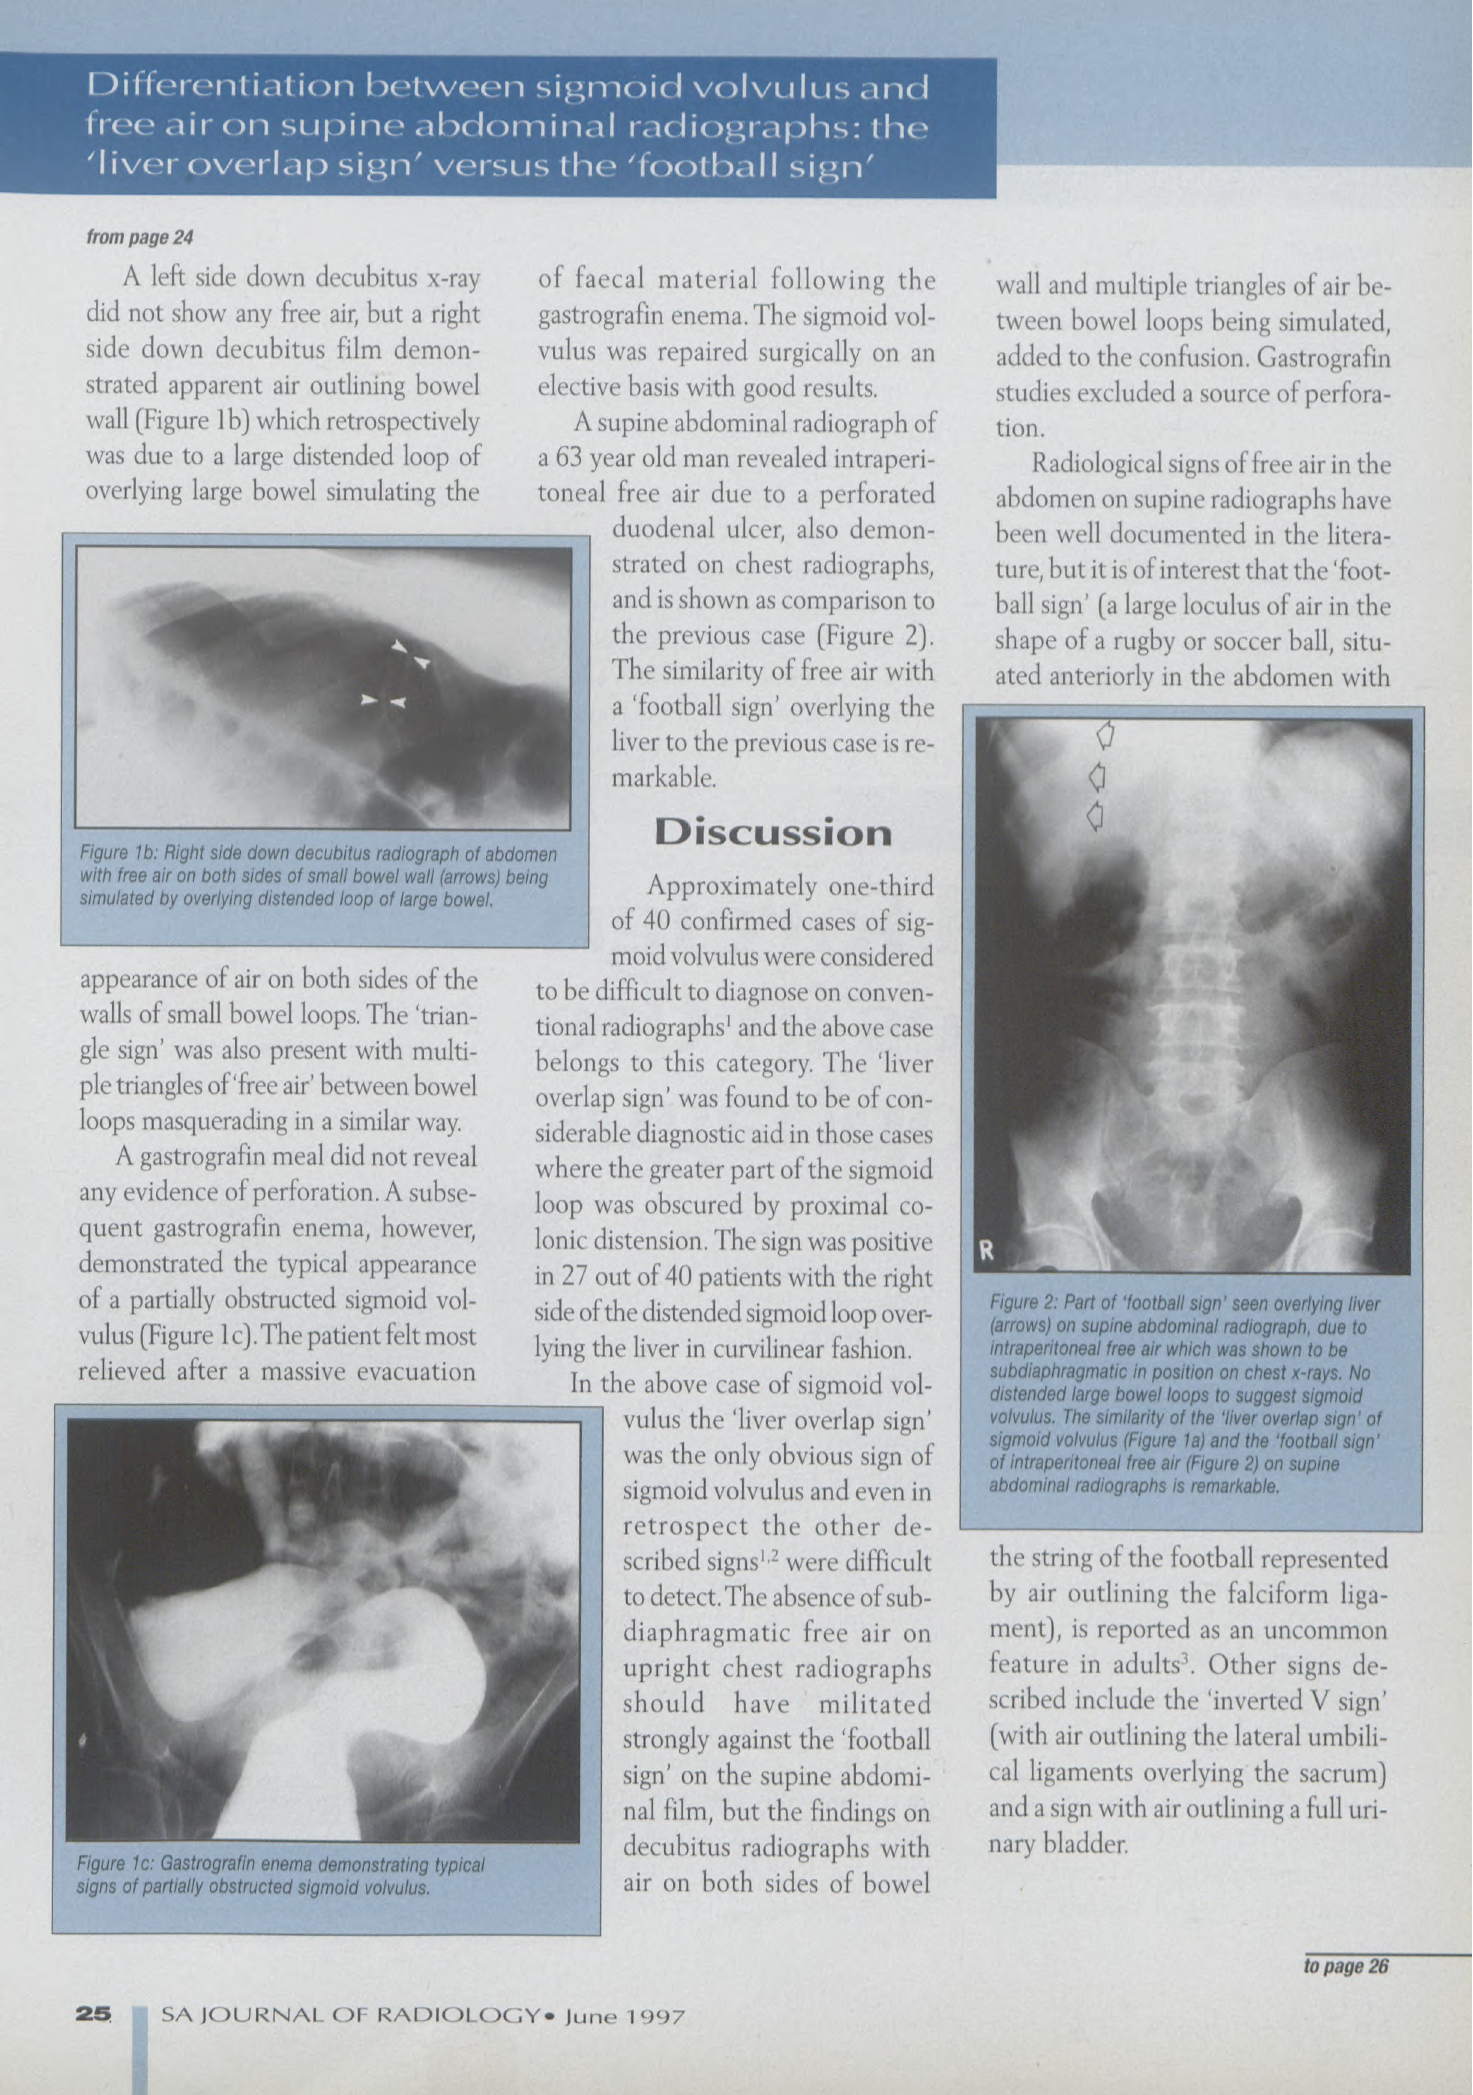
Figure 1 c: Gastrografln enema demonstrating typical signs of partially obstructed sigmoid volvulus.